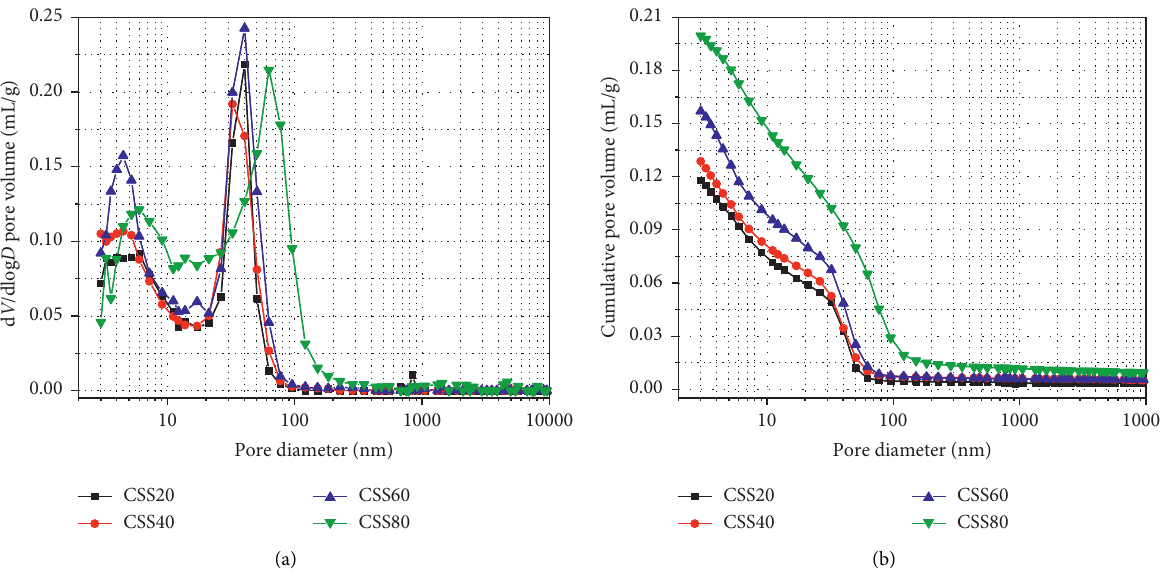
Figure 9: Pore volume distribution of blended cement paste containing steel slag powder. (a) Differential distribution. (b) Cumulative distribution.